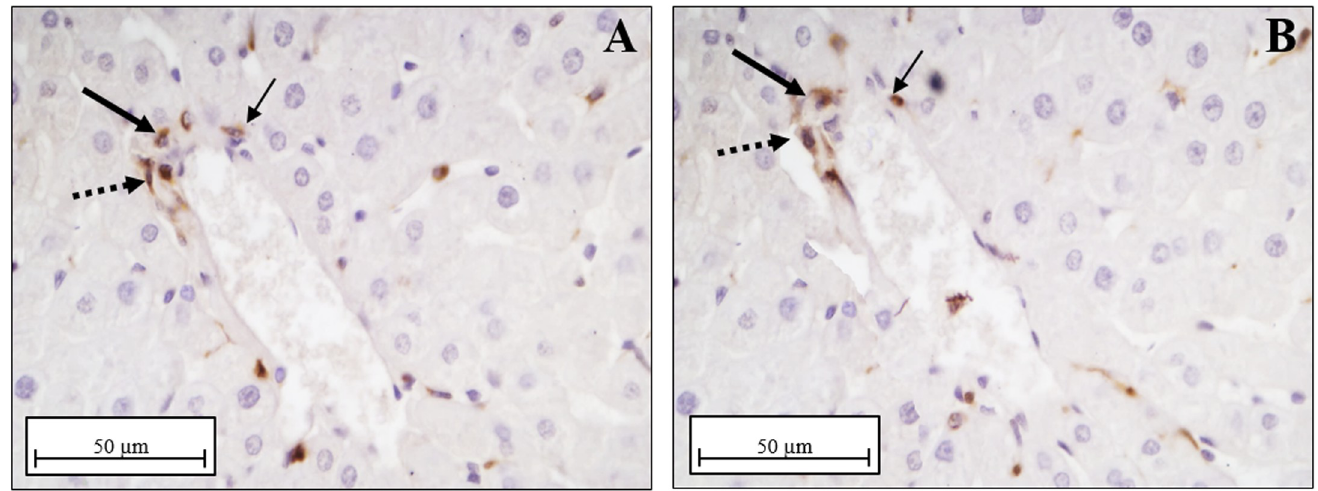
Fig 11. CD68 and UCP2 localization in N rats. Immunostaining for CD68 (A) and UCP2 (B) reelevates colocalization of the two antigens. Different arrows were used to compare the same cells positives to the both antibodies used (big arrow, thin arrow, dashed arrow). Magnification used: 40X; Scale bar 50 μ m.